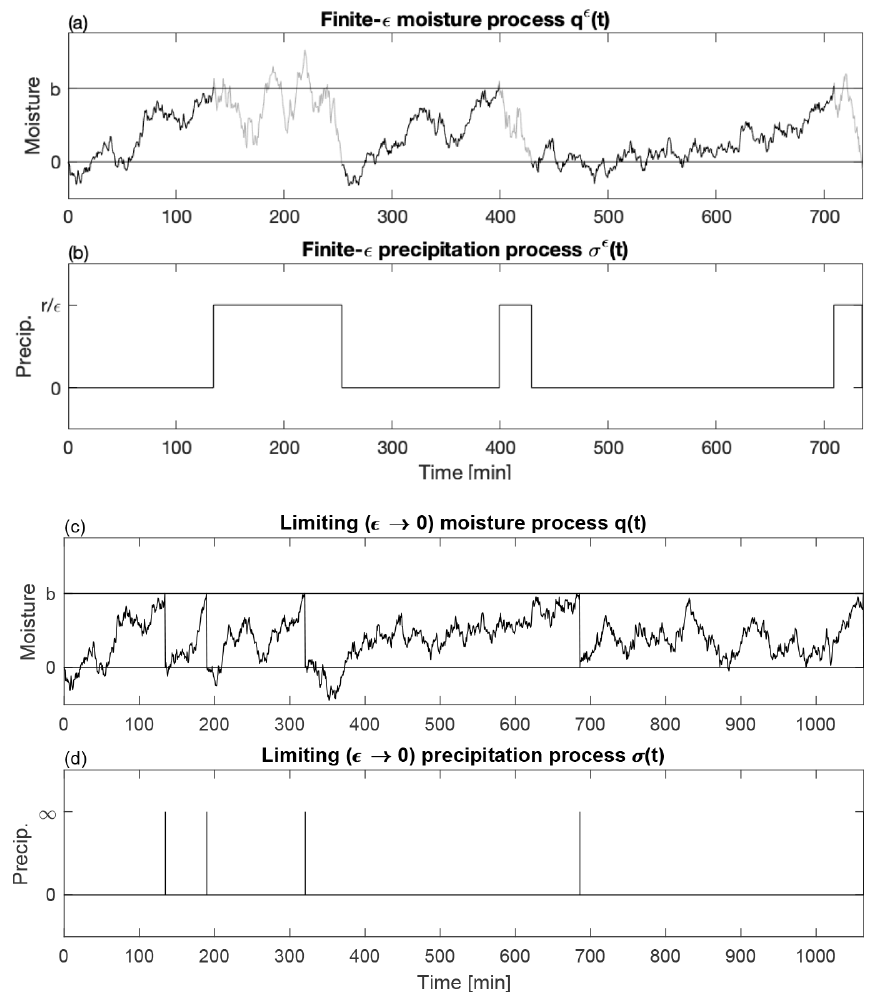
Figure 2. Realizations are plotted of the processes (a) q (cid:15) ( t ), (b) σ (cid:15) ( t ) for rain rate r/(cid:15) defined in Eq. (2) with (cid:15) > 0 and, on the other hand, the limiting ( (cid:15) → 0) processes (c) q ( t ) and (d) σ ( t ) defined in Eqs. (4) and (7), respectively. Here m = r = 0 . 4mmh − 1 with (cid:15) = 0 . 01. Thus, the effective rain rate is 40mmh − 1